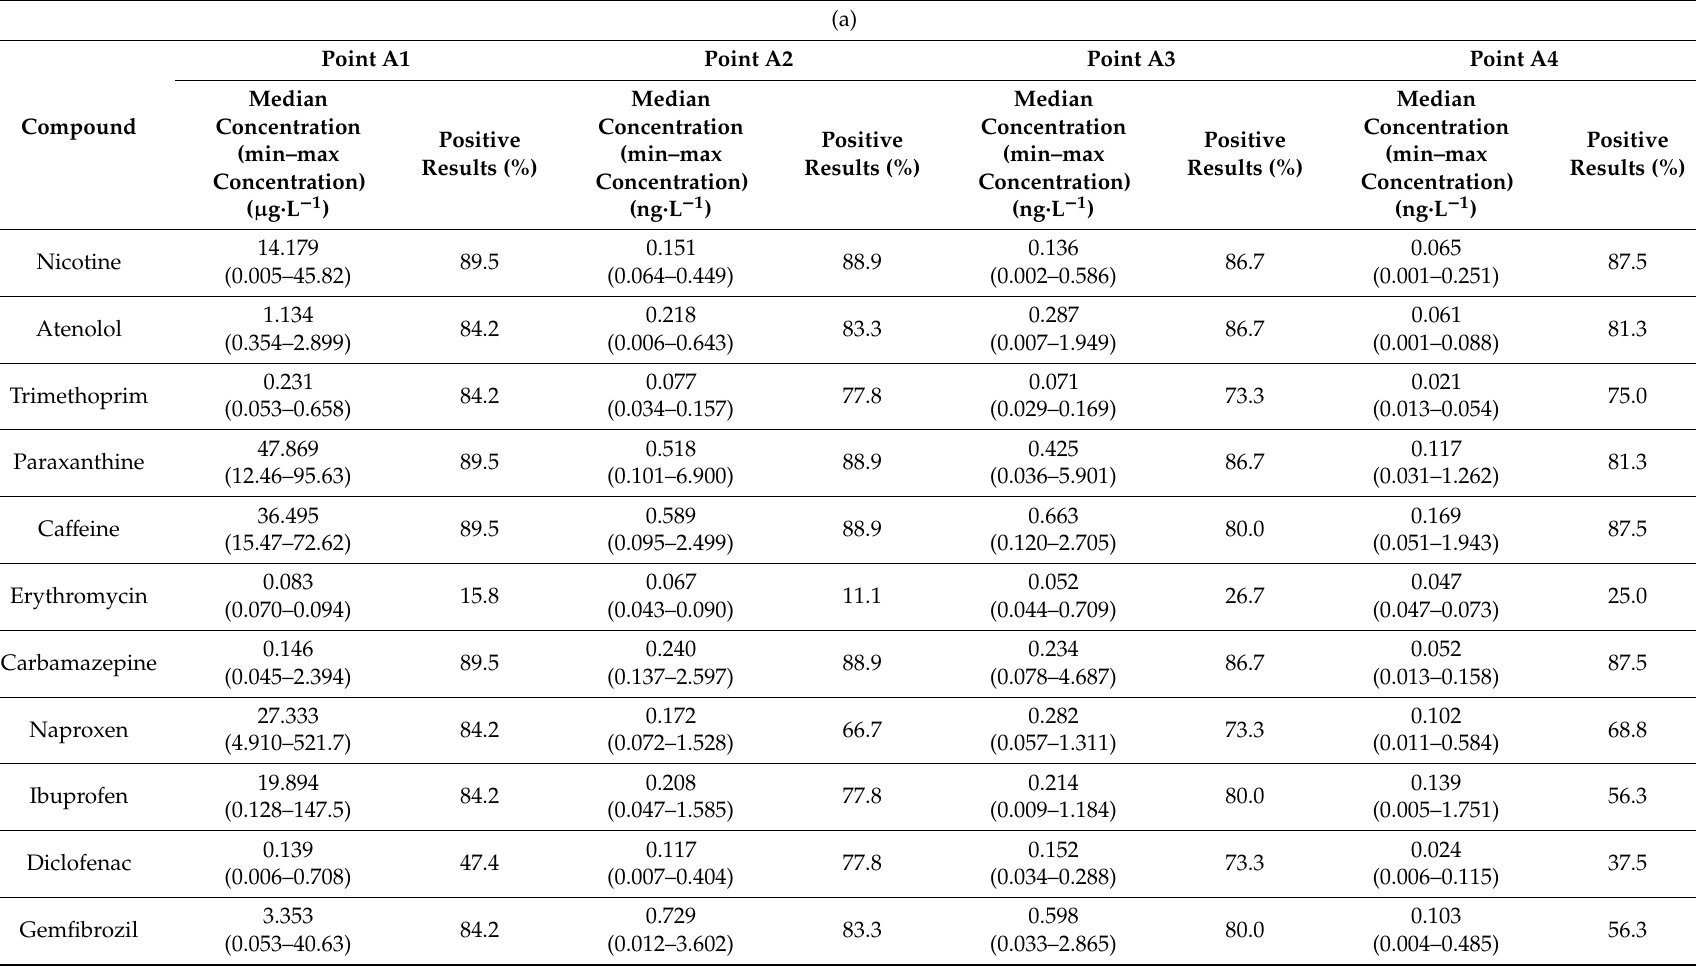
Table 2. Median concentrations, range of detected concentrations, and positive analysis for target pharmaceuticals. ( a ) C-WWTP1, ( b ) C-WWTP2, ( c )